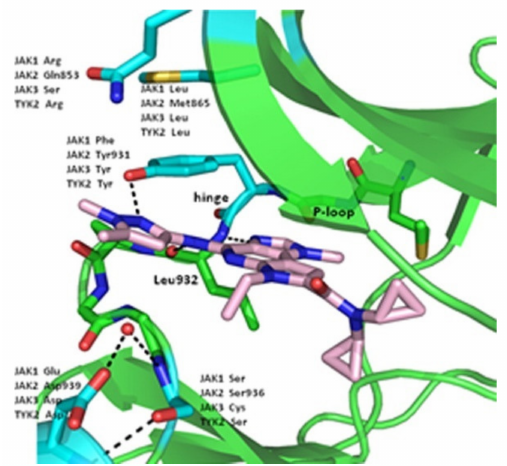
Figure 52. X-ray crystallized BMS-911543 ( 45 ) bound to the kinase catalytic domain of JAK2; Pick = BMS-911543’s Carbon; Green = JAK2’s carbon green; Cyan = residues near the C-4 group, which differ in the JAK family; dashed lines = hydrogen bonds